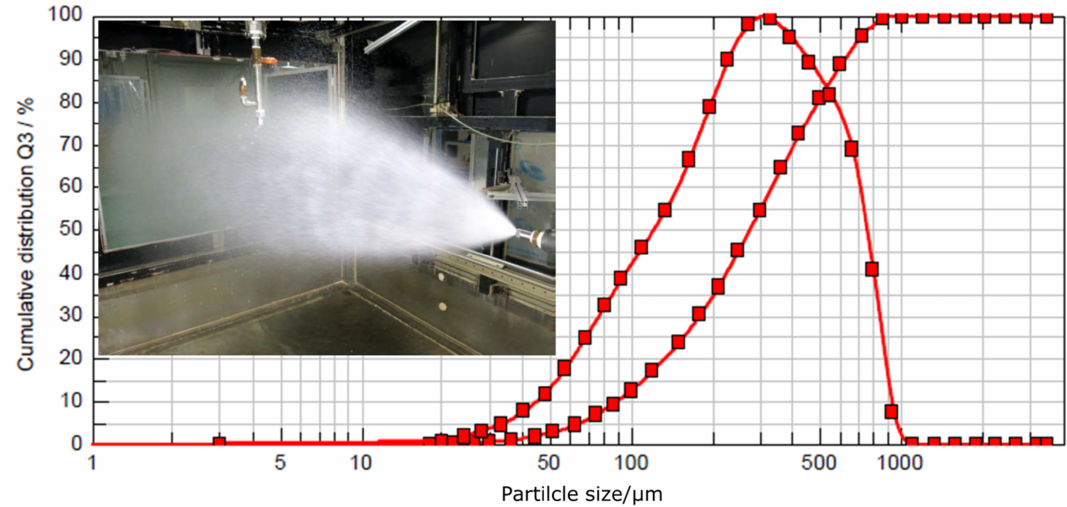
Figure 3. Spray-nozzle test to verify spray angle and droplet-size distribution.